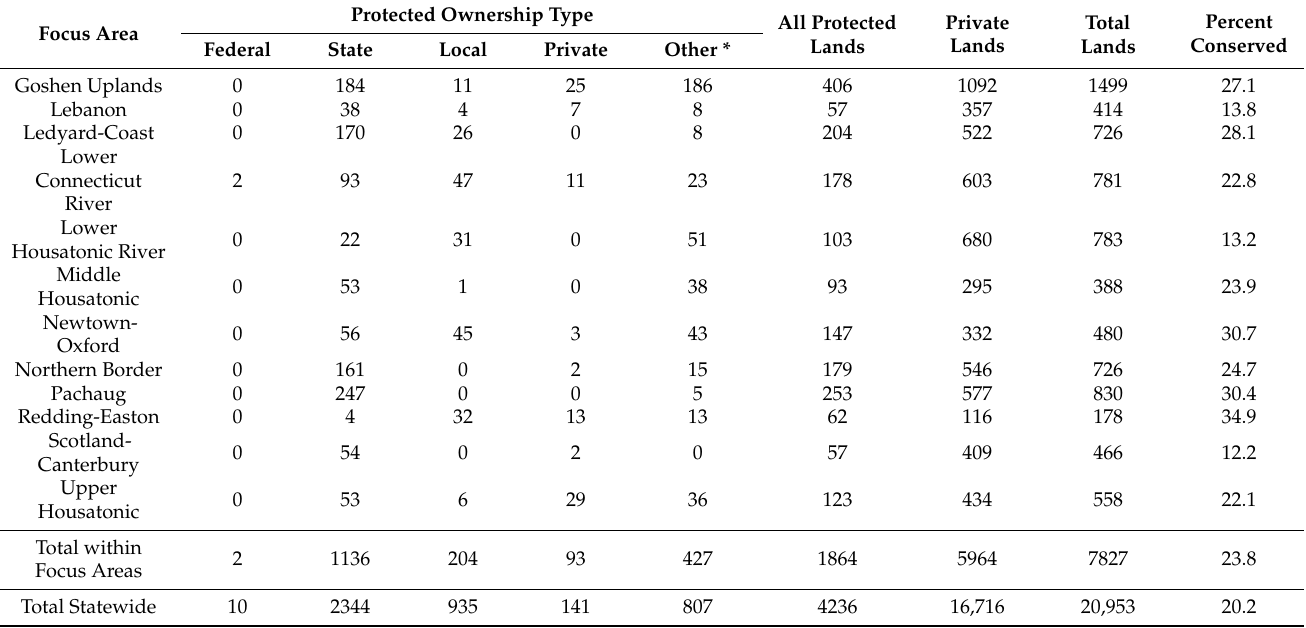
Table 7. Hectares of young forest and shrubland vegetation types in complexes ≥ 2 ha in size, by ownership type and protection status, in New England cottontail Focus